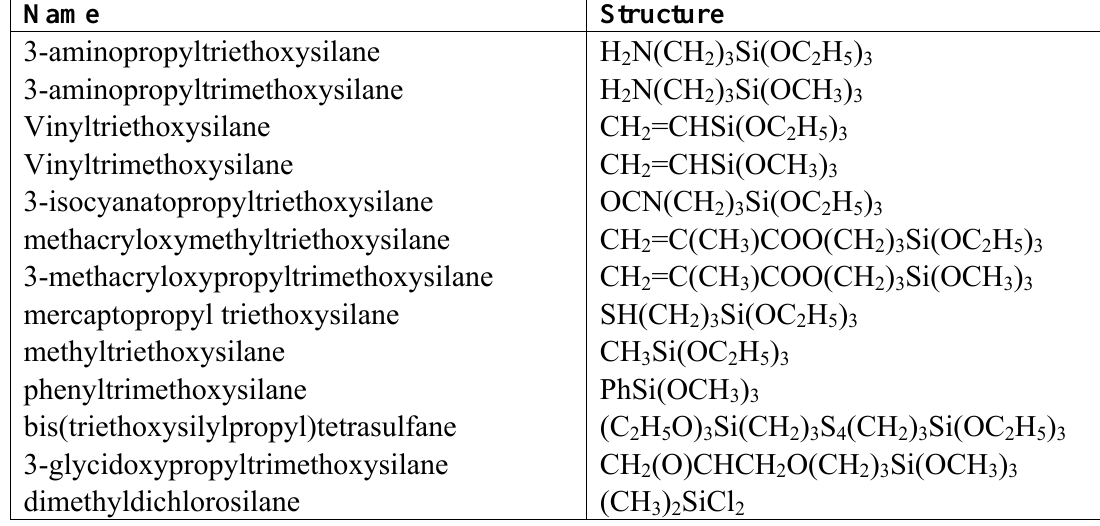
Table 1. Typical silane coupling agents used for surface functionalization of mesoporous silica.